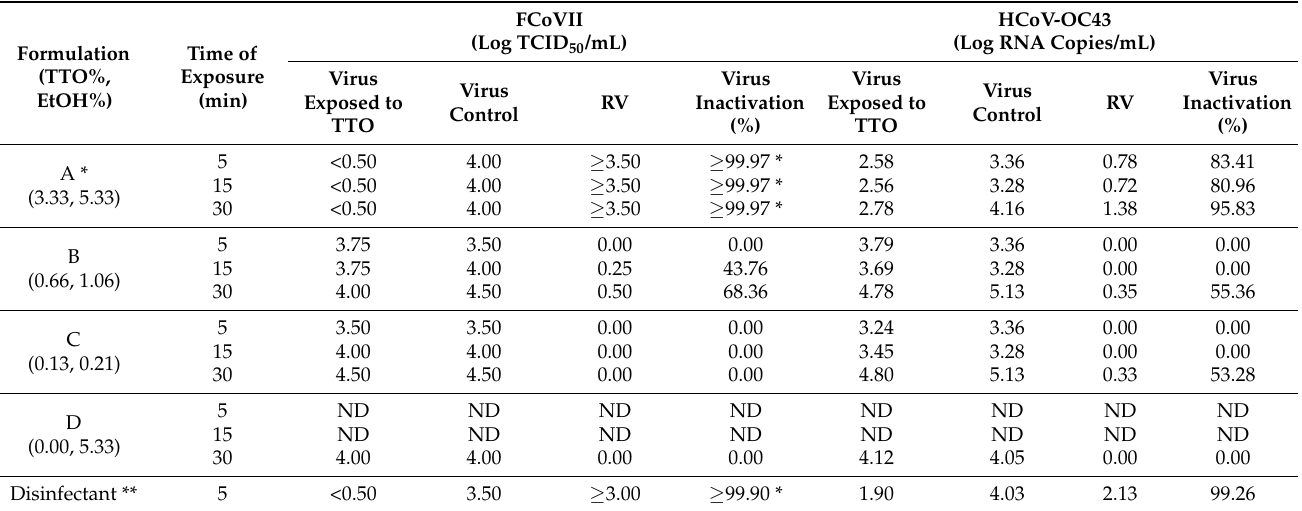
Table 1. Virucidal activity of TTO against FCoVII and